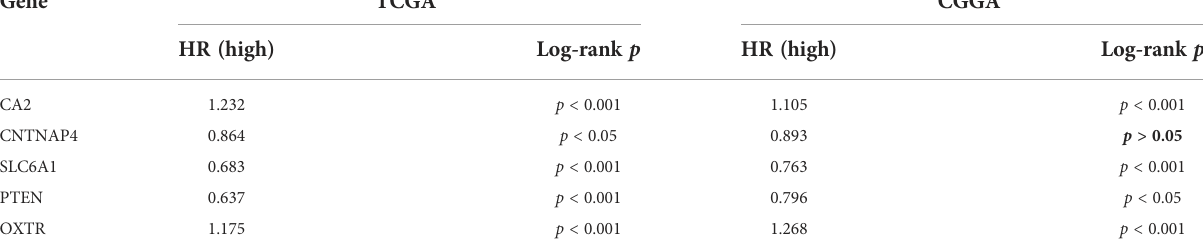
TABLE 2 K – M survival analysis of fi ve GSRS genes in TCGA and